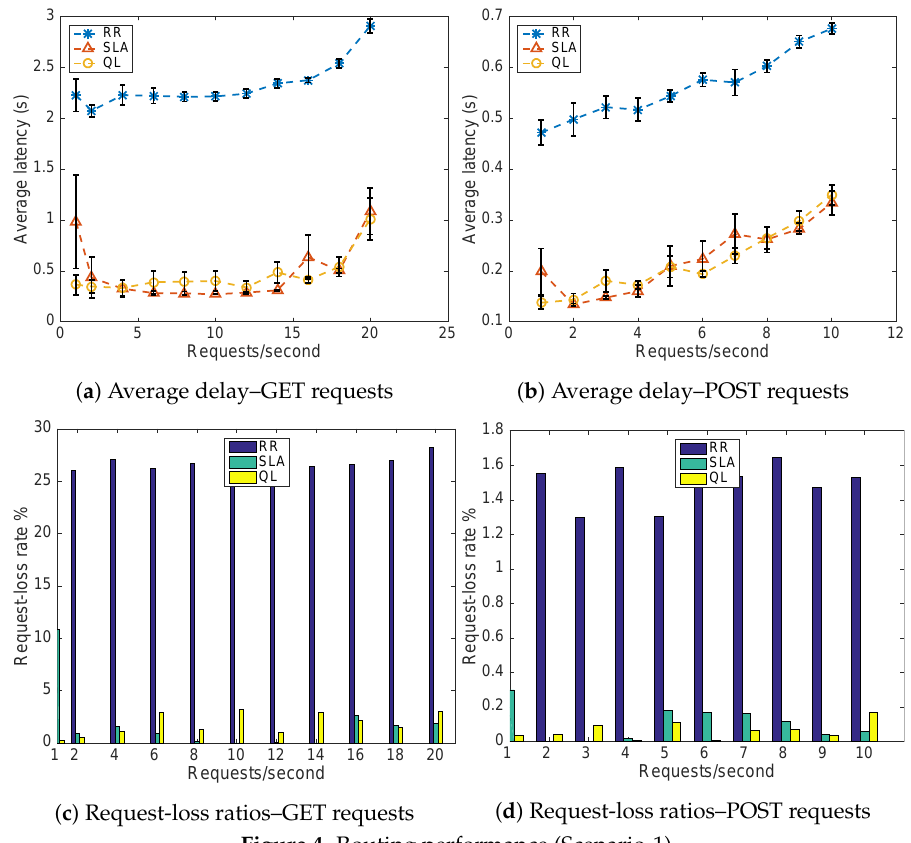
Figure 4. Routing performance (Scenario-1). Table 3. Server (feeder link) selection count for Scenario-1 (GET).